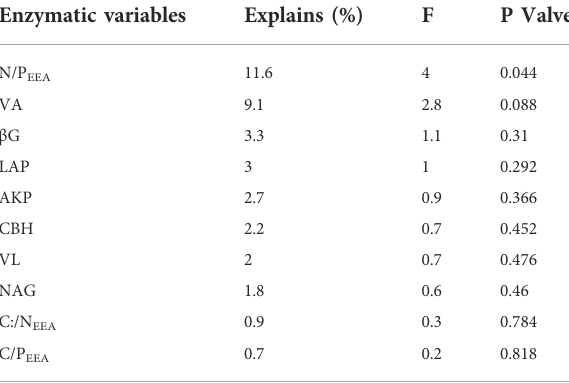
TABLE 3 Results of redundancy analysis of soil microbial variation and enzymatic variables, determined by forward selection procedure with unrestricted permutation